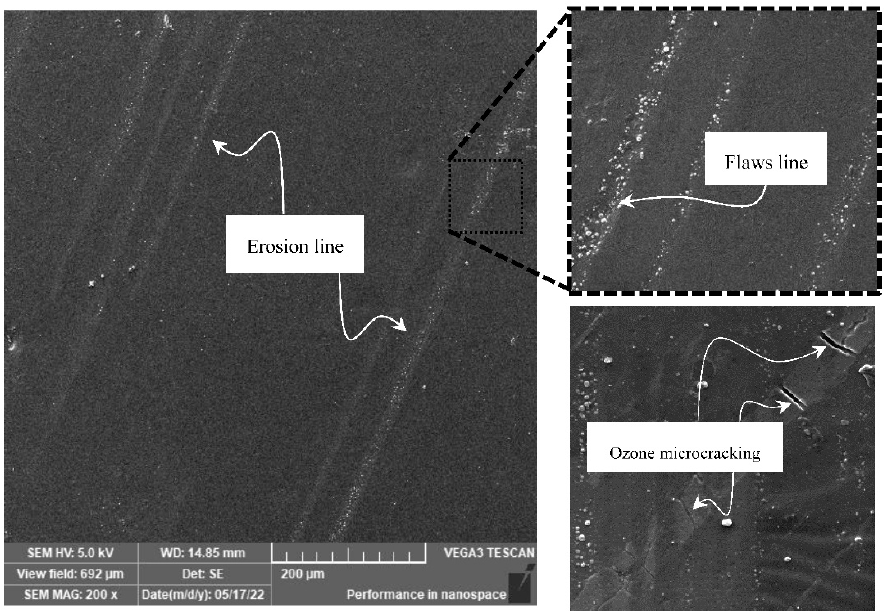
Figure 2. SEM micrographs of MRE samples after 30 days of weathering durability.